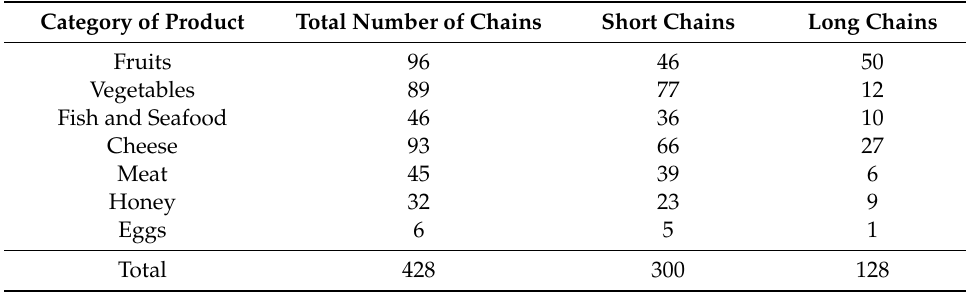
Table 2. Number of chains used by producers for distribution of products in the